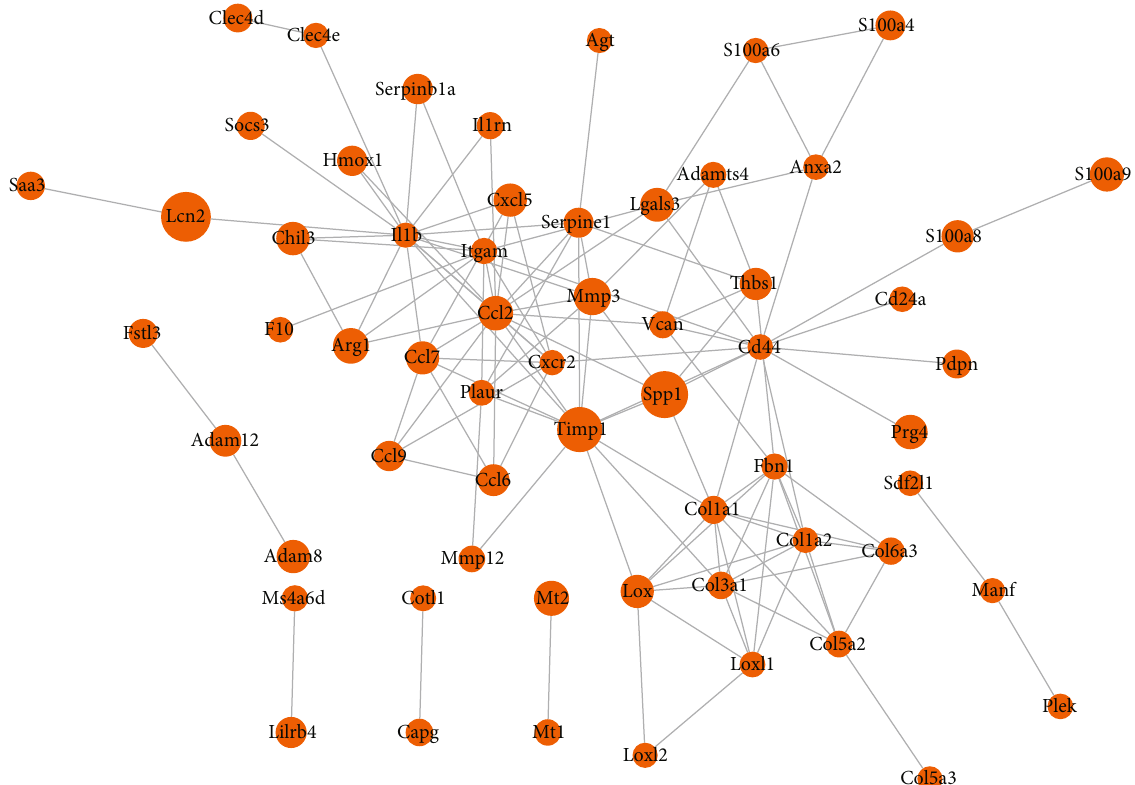
Figure 3: Protein-protein interaction (PPI) network of top 100 upregulated DEGs. The size of the point represents the size of the upregulation, and topological degree was used as the criteria for node